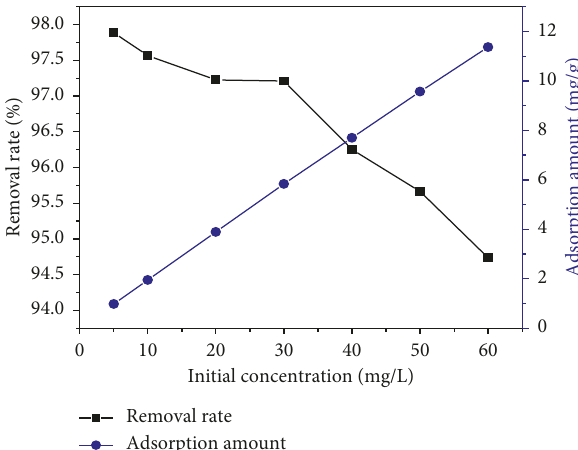
Figure 5: Effect of the initial uranium concentration by modified rice